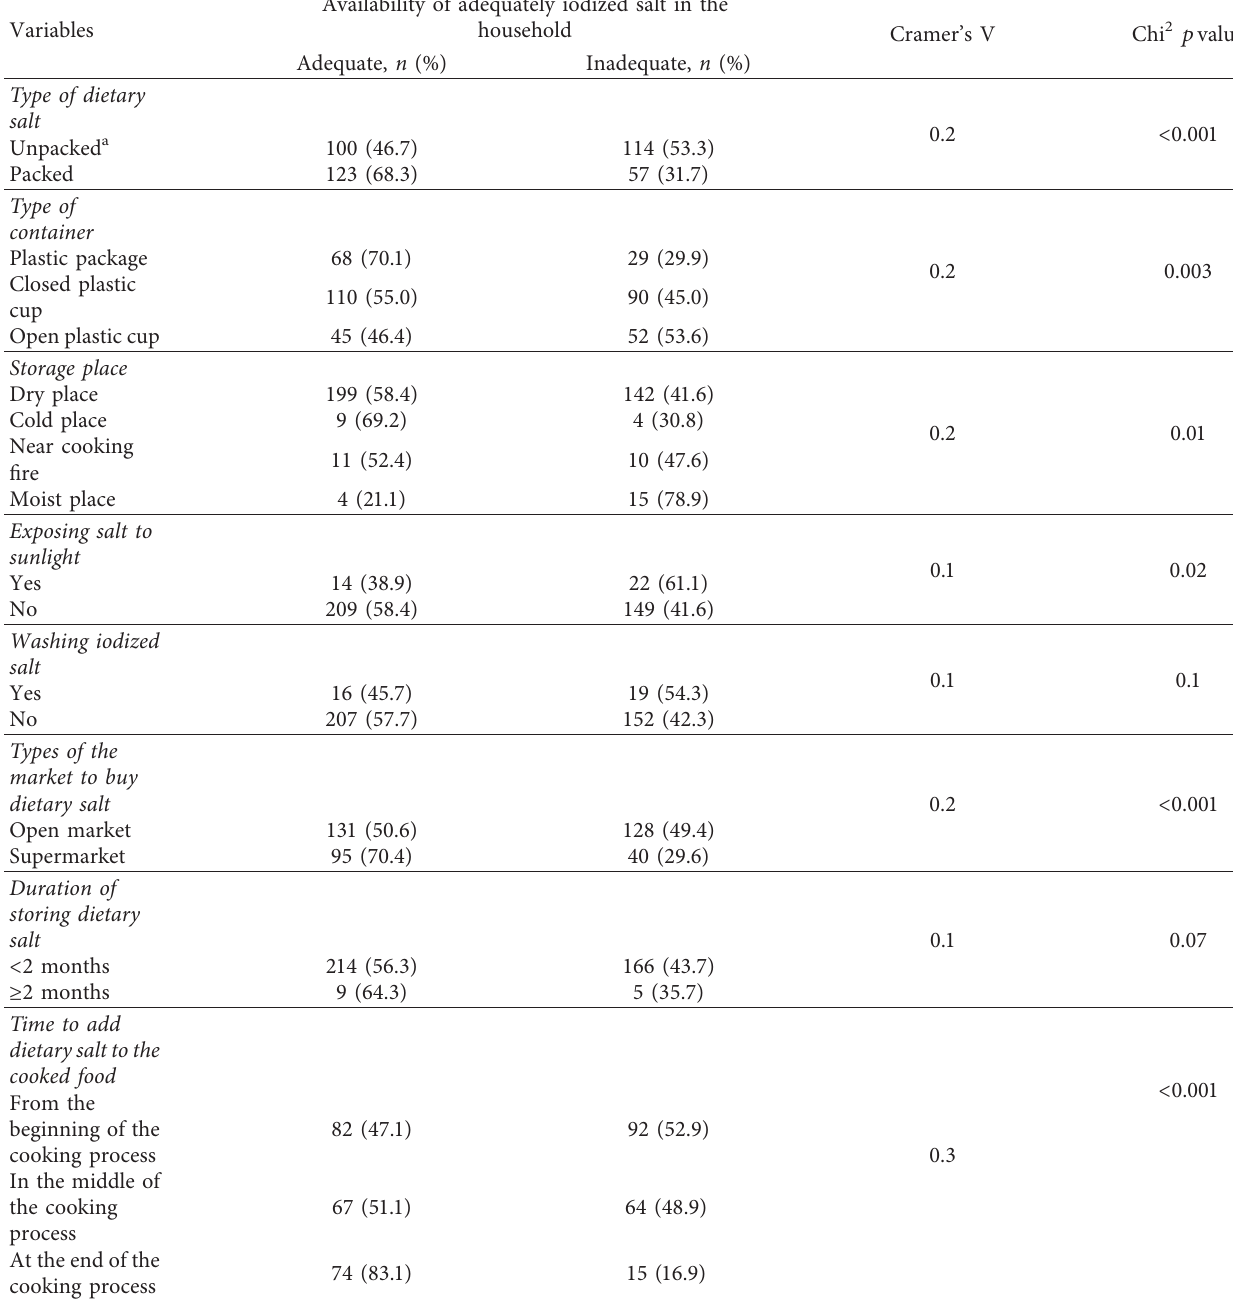
Table 2: Dietary salt handling practice of householders in Kore Town, Southeast Ethiopia,